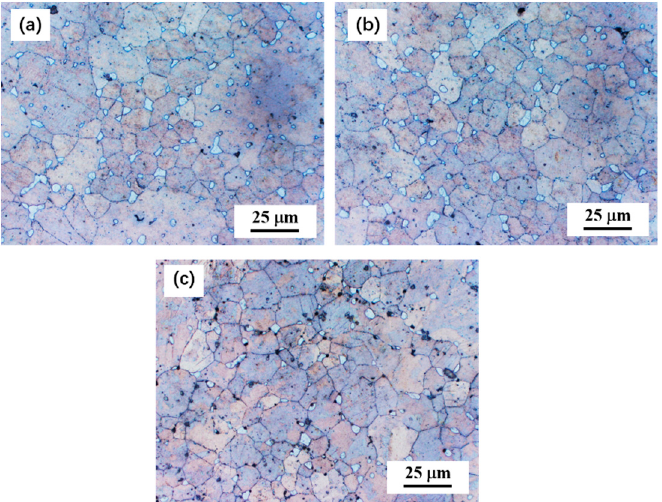
Figure 10. Optical images of the double-peak aged alloys: ( a ) ZA64, ( b ) ZAT641, and ( c ) ZAT642 .